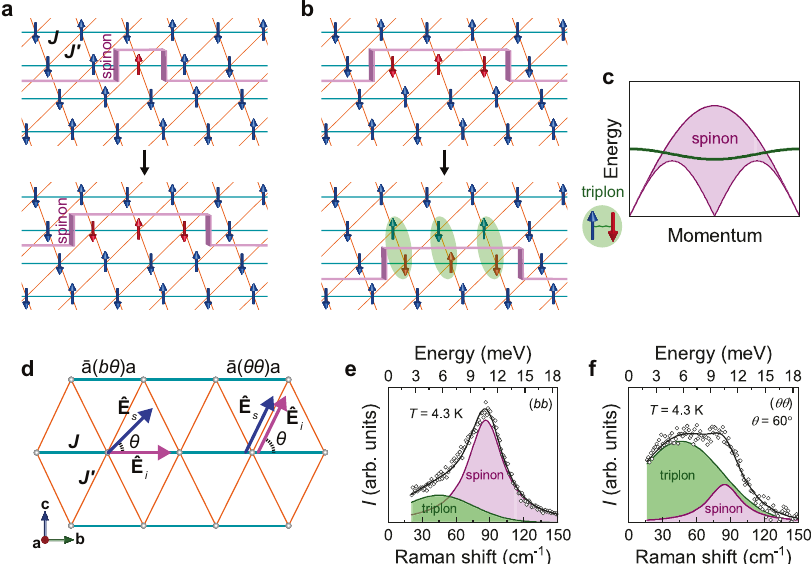
Fig. 1 Schematic illustration of spinons and triplons in anisotropic triangular antiferromagnets. a Flipping a local spin (red arrows) creates two domain walls (pink fold), corresponding to spinons carrying S = 1/2. The two spinons propagate freely along the chain direction. b The spinons can hop between the chains by forming their bound states (green oval). Pairs of the con fi ned spinons constitute triplons carrying S = 1. c Dispersions of the spinon continuum (pink shading) and triplon (green line). d Sketch of ( b θ ) and ( θθ ) polarization con fi gurations for angle-resolved Raman experiments. e , f Representative magnetic Raman continuum in ( θθ ) polarization with θ = 0° and 60°. The magnetic continuum is decomposed into two spin excitations: triplons (green shading denoted by T) and two spinon-antispinon pair excitations (pink shading denoted by S). The triplon and spinon contributions are modeled by Gaussian and Lorentzian line pro fi les, respectively.